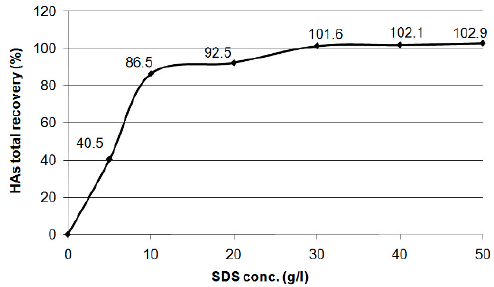
Figure 2. The effect of the eluent (SDS) concentration on the HAs desorption from Porapak P sorbent.